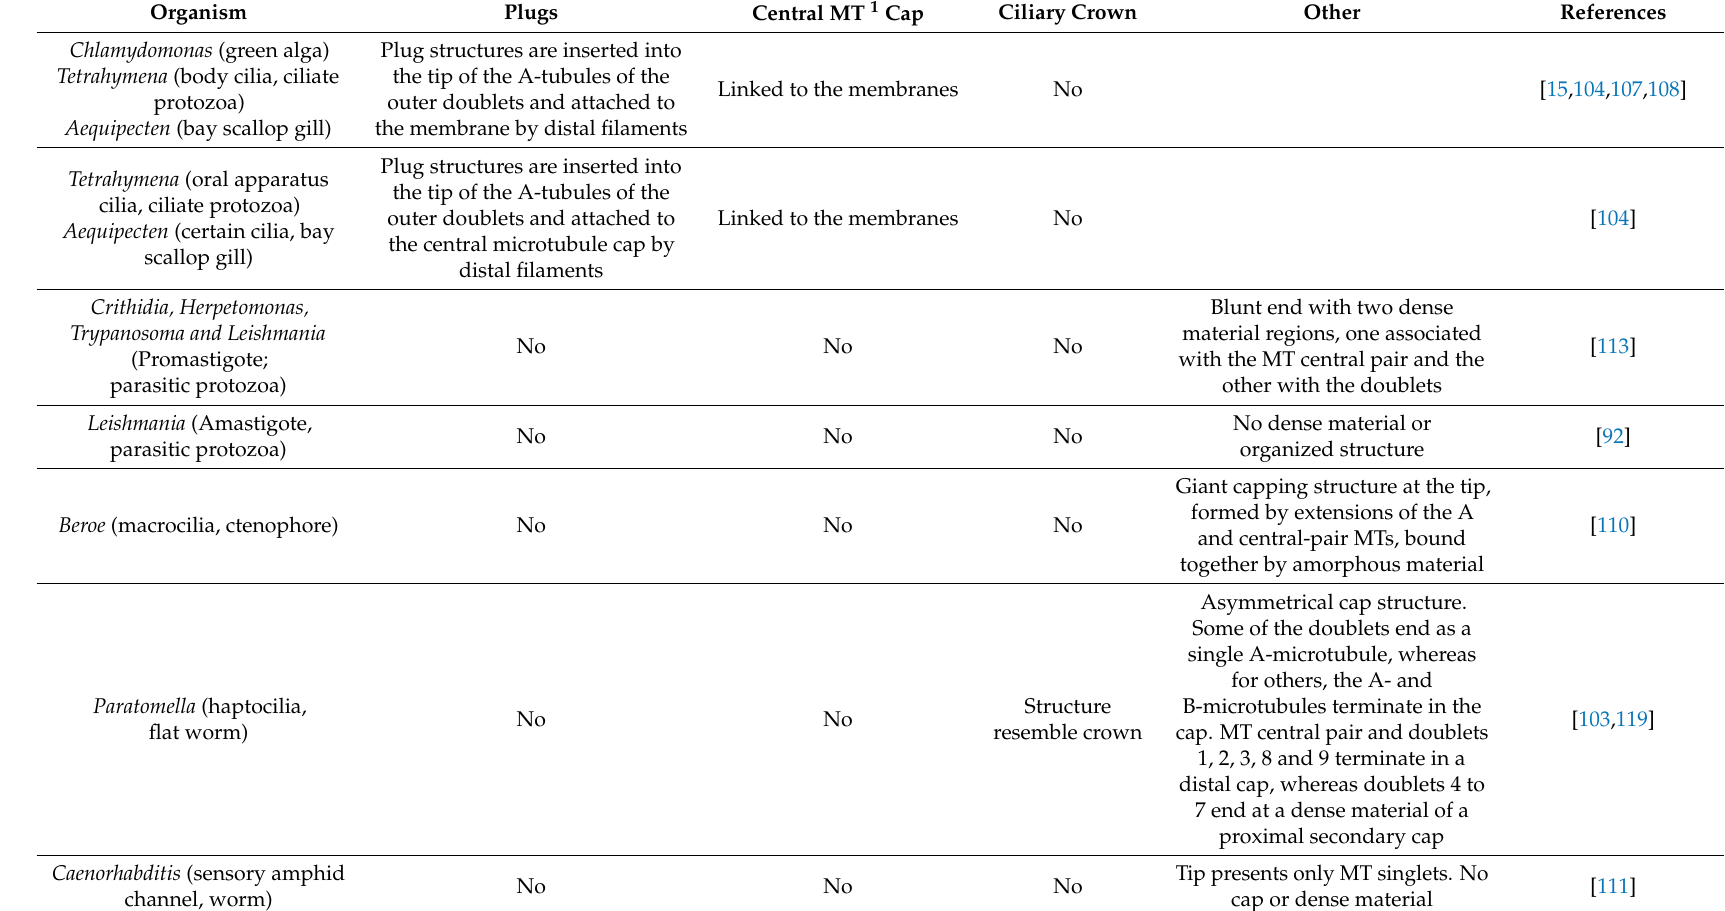
Table 2. Examples of different distal domain